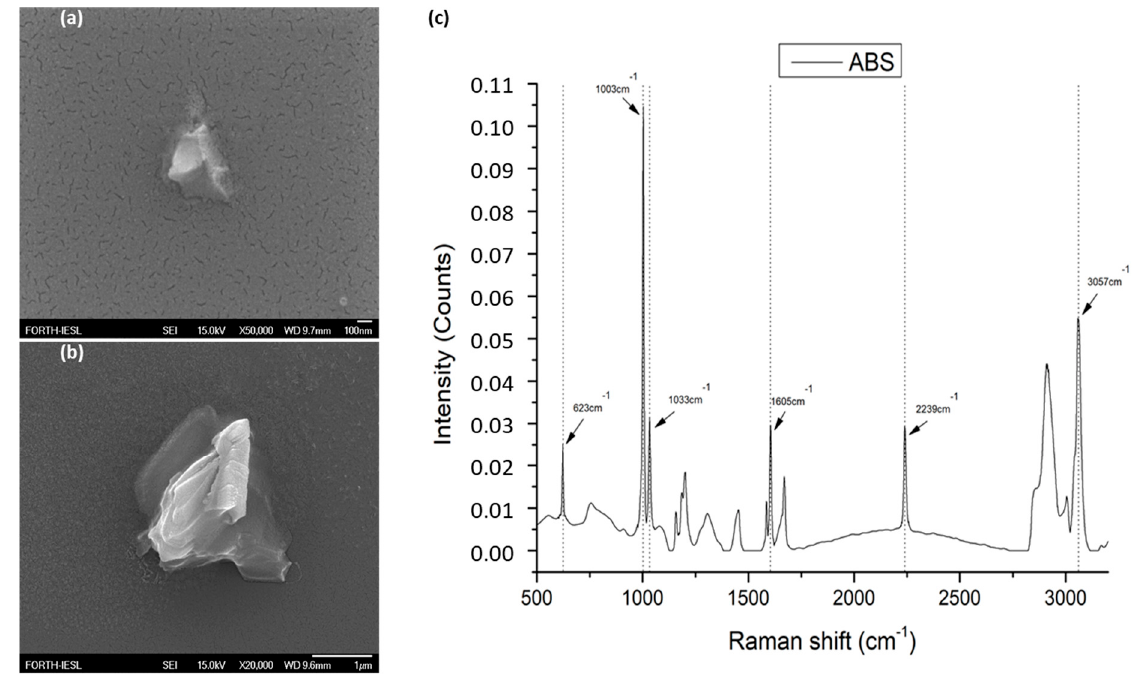
Figure 1. ABS powder characterization through FE-SEM indicative images from MPs: ( a ) one of the smallest MPs with approximately 0.3 µ m diameter; ( b ) a MP with around 2 µ m diameter; ( c ) the characteristic Raman spectrum measured indicating the identified Raman peaks present in the microplastics in radish roots.